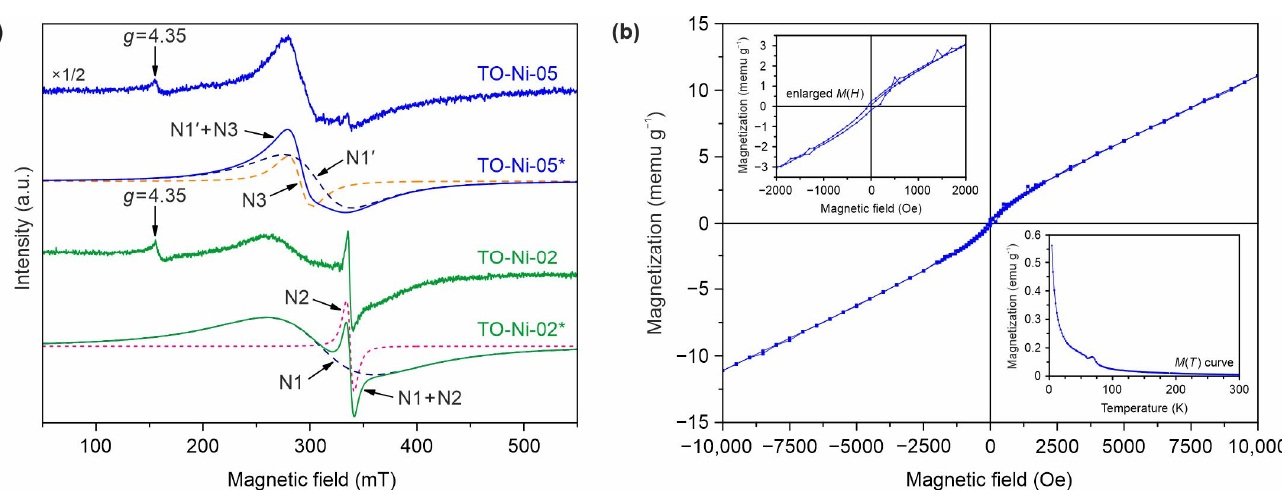
Figure 6. ( a ) Experimental and deconvoluted (marked by *) EPR spectra for TO-Ni-02 and TO-Ni-05 samples at 290 K. ( b ) Magnetic hysteresis loop at room temperature for TO-Ni-05 material. The insets show the enlarged view of the M ( H ) curve in a low magnetic field and the temperature dependence of magnetization.